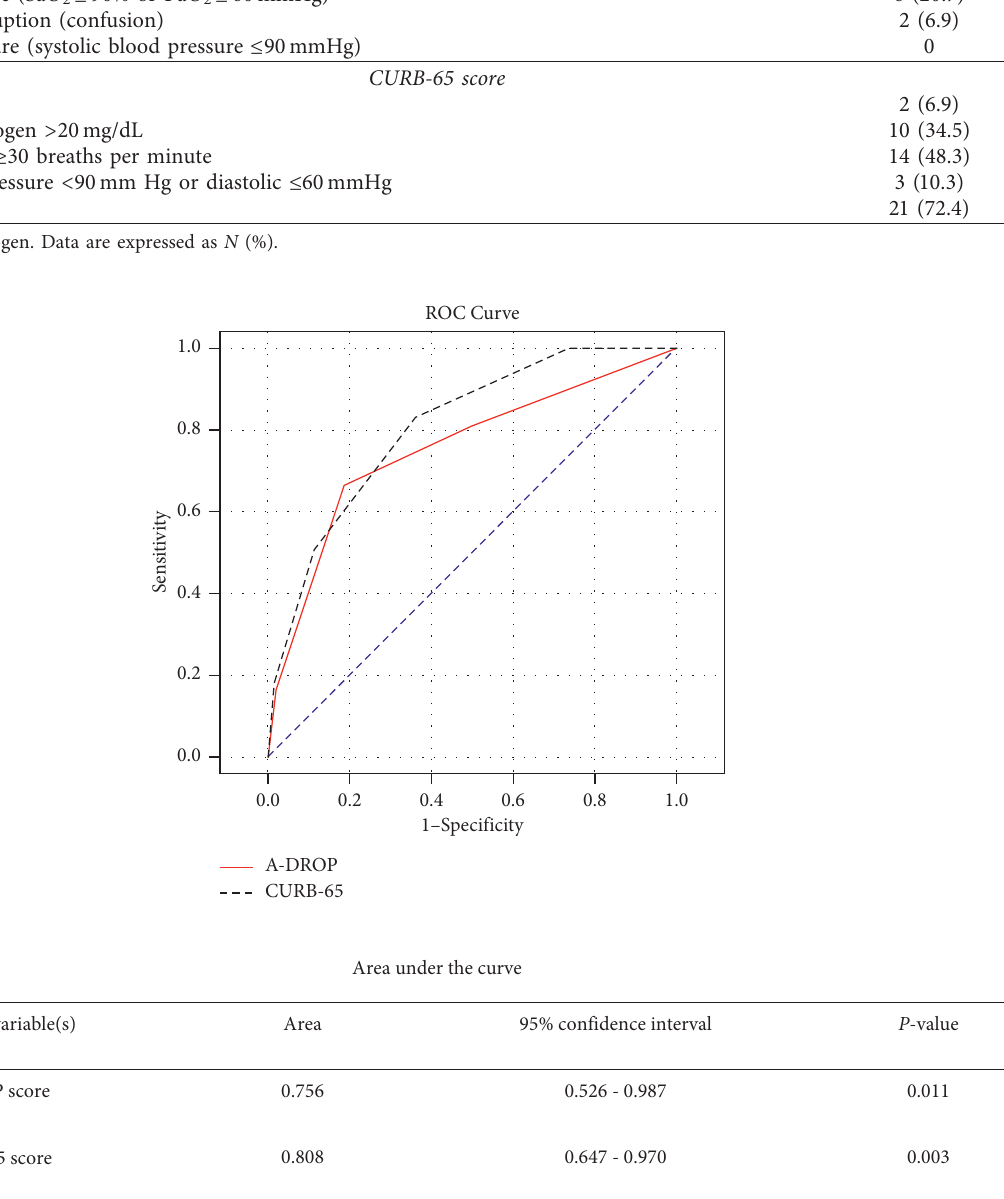
Figure 2: Receiver operating characteristic (ROC) curves for (—) A-DROP score and (- - -) CURB-65 score to predict the 30-day mortality rate in patients with community-acquired pneumonia. (....) Reference